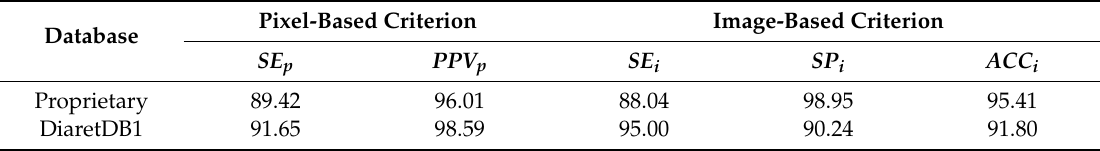
Figure 7. Average accuracy for EX classification over the validation set obtained during MLP training for varying the number of hidden neurons and the regularization parameter. Table 3. Results for the detection of